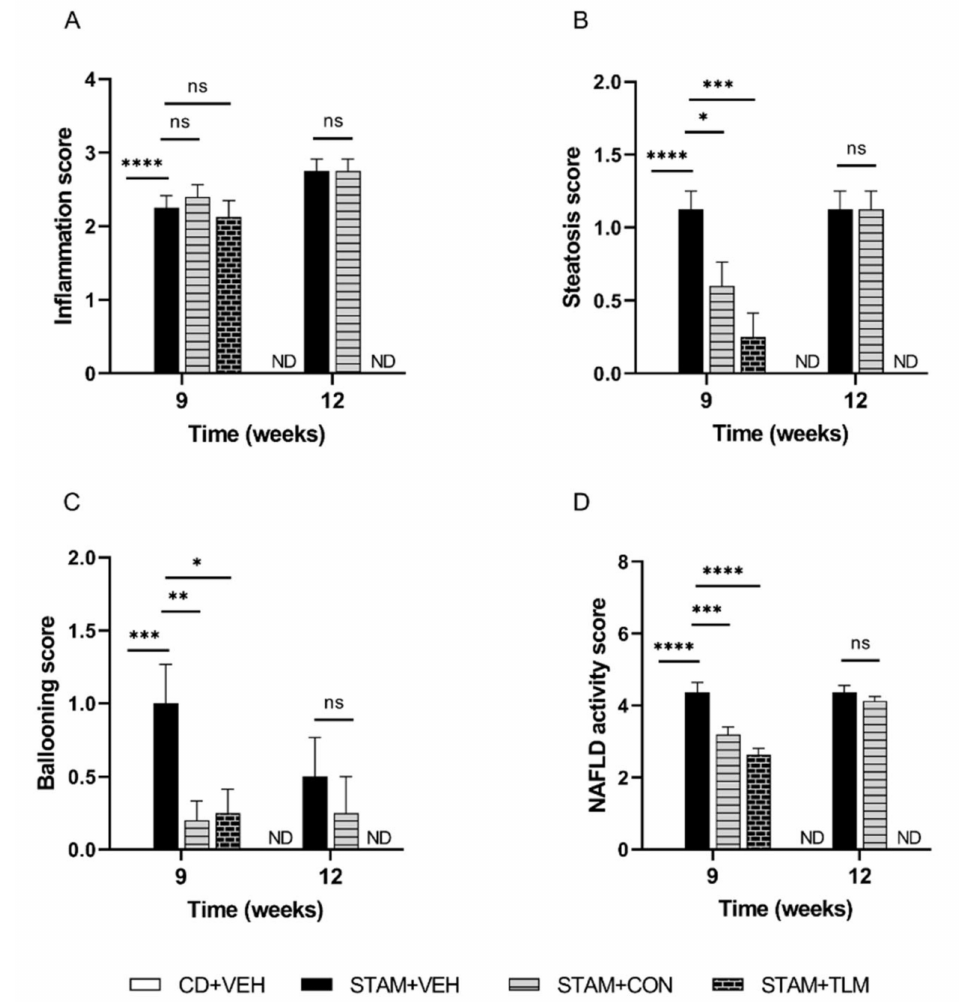
Figure 6. NAFLD activity score (NAS) in the STAM™ study. Histopathology was evaluated in H&E-stained liver sections, and the NAS score was calculated. The components ( A ) inflammation, ( B ) steatosis, ( C ) ballooning, and ( D ) the composite score, were evaluated at both 9 and 12 weeks of age (euthanasia 1 and 2, respectively). CD + VEH: group of control diet mice receiving sham gavage (vehicle); STAM + VEH: group of STAM mice receiving sham gavage (vehicle); STAM + CON: group of STAM mice receiving the 9-strain bacterial consortium daily; STAM + TLM: group of STAM mice receiving Telmisartan daily. ND: not determined for the CD + VEH and STAM + TLM groups at 12 weeks. ns: not significant. *, **, ***, **** p ≤ 0.05, ≤ 0.01, ≤ 0.001, and ≤ 0.0001, respectively, versus STAM +